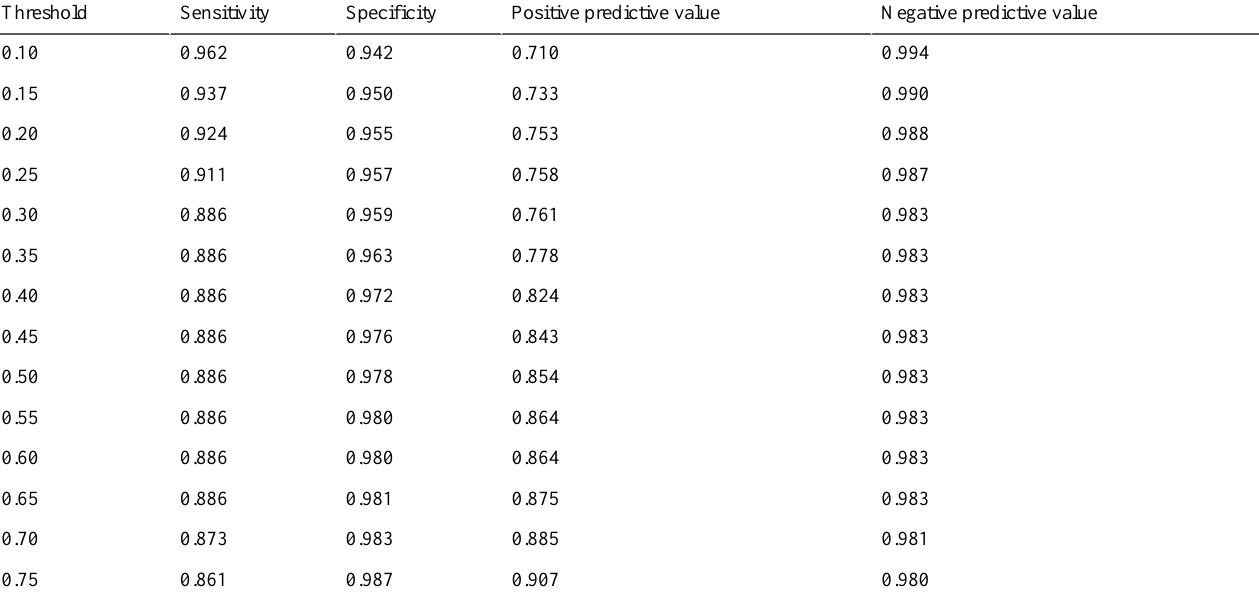
Table 2. Person-level performance (sensitivity, specificity, and positive and negative predictive values) corresponding to various probability thresholds for classifying an individual as having a second breast cancer event a